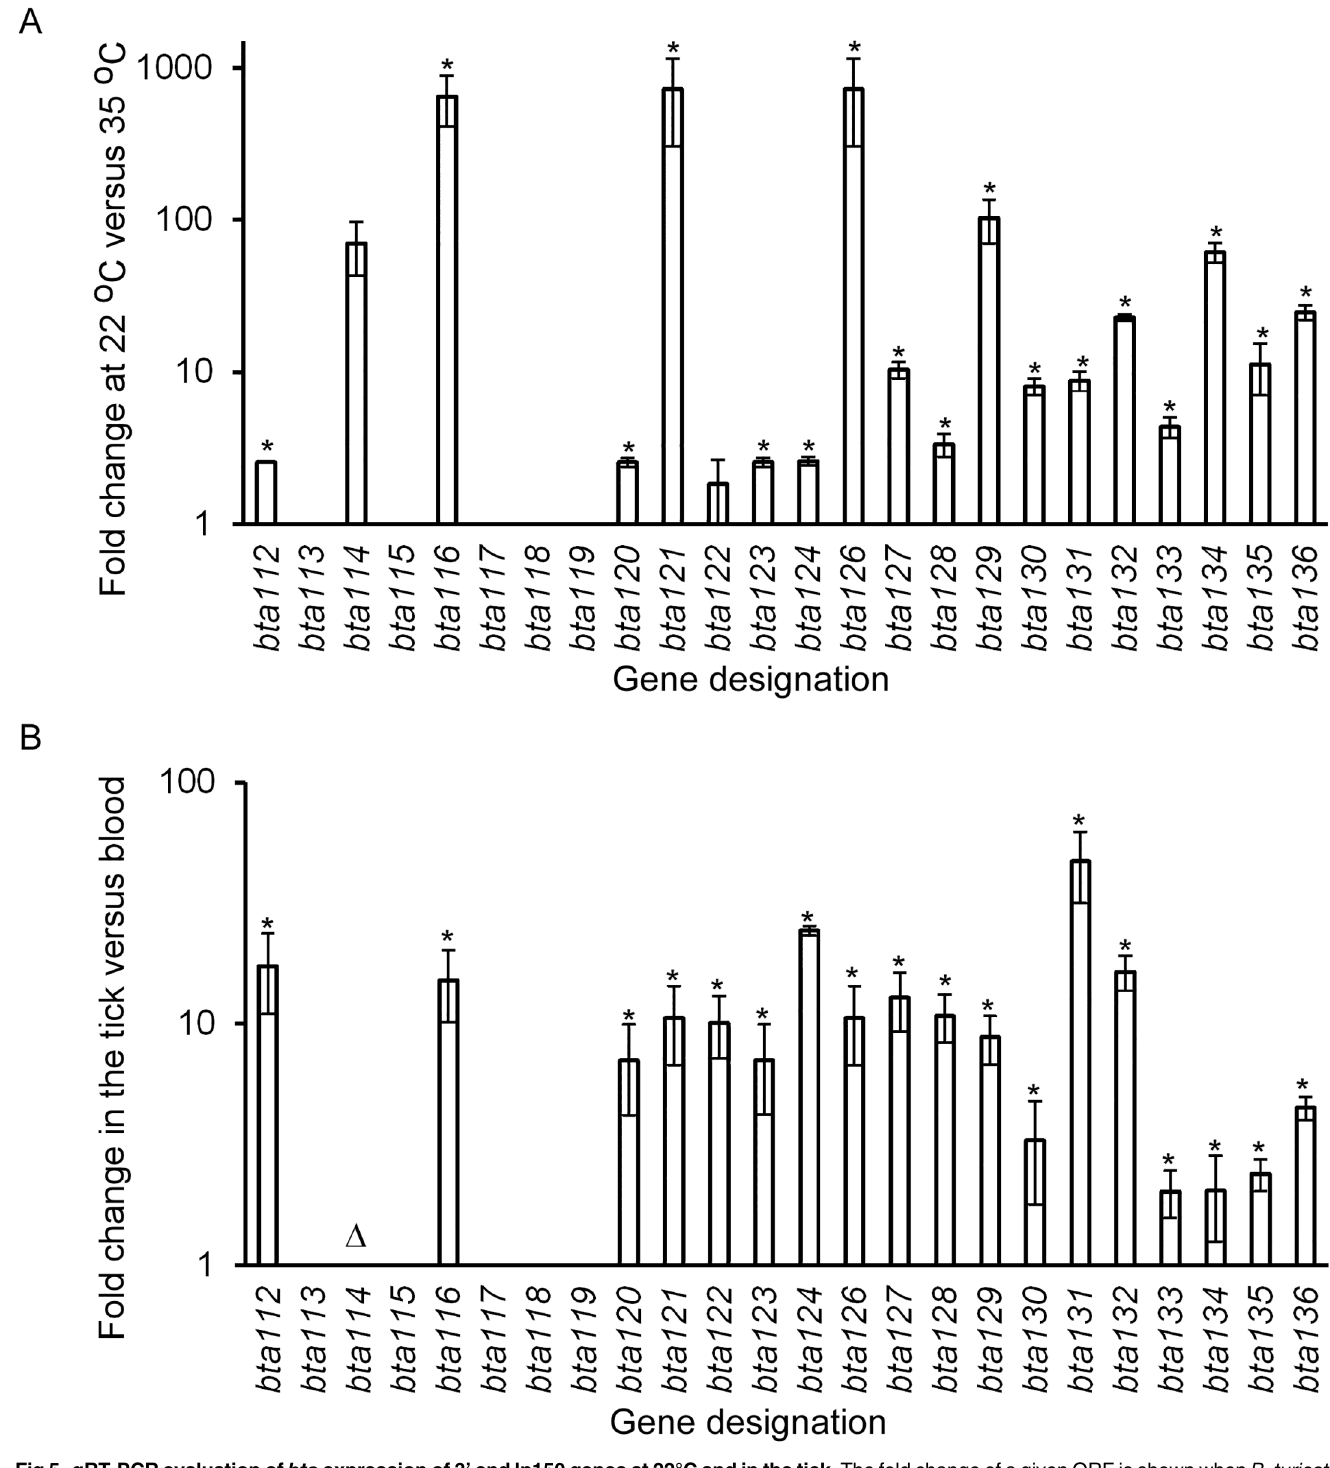
Fig 5. qRT-PCR evaluation of bta expression of 3 ’ end lp150 genes at 22°C and in the tick. The fold change of a given ORF is shown when B . turicatae was grown at 22°C relative to 35°C (A), and in infected ticks versus infected murine blood (B). Ninety-five percent confidence intervals are shown at the top of each bar, and asterisks indicate significant differences of expression between a given gene at 22°C versus 35°C (A) and infected ticks versus blood (B), as determined by a t test ( p -value < 0.05). The triangle represents transcript that was only detected in infected ticks (B).